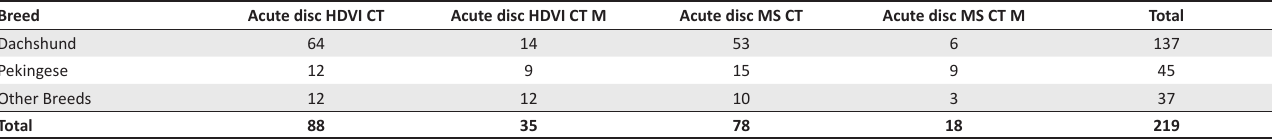
TABLE 1: Detection of acute intervertebral disc extrusions in different breeds of dogs using high-definition volumetric computed tomography, high-definition volumetric computed tomography with myelography, multi-slice computed tomography and multi-slice computed tomography with myelography.